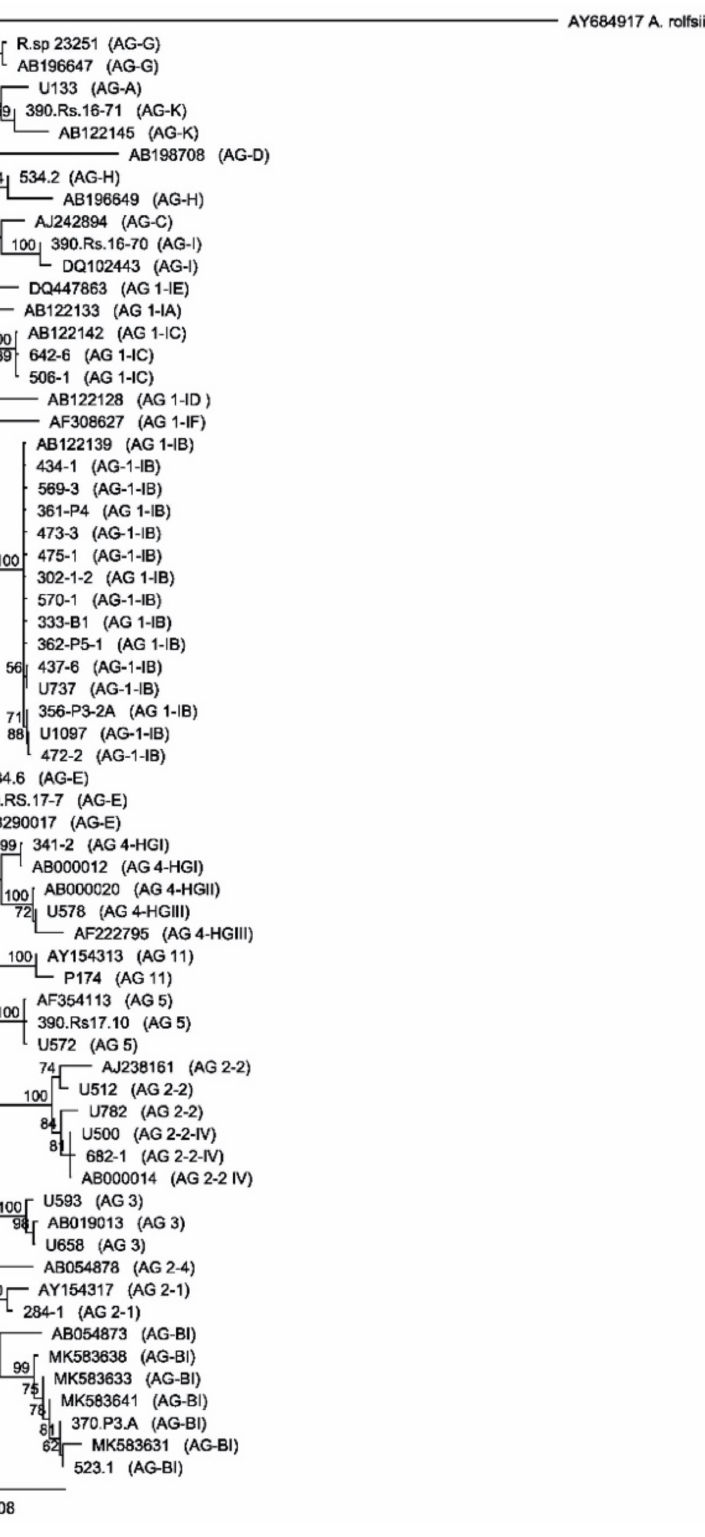
Figure 1. Neighbor-joining consensus tree based on the alignment of 65 ITS sequences of Rhizoctonia solani and binucleate Rhizoctonia . Twenty-eight sequences were retrieved from Genbank, 17 were from lettuce isolates, 20 were isolated from other crops, and Athelia rolfsii (AY684917) was used as an outgroup. Bootstraps values (1000 replicates) are indicated only for branches with a value higher than